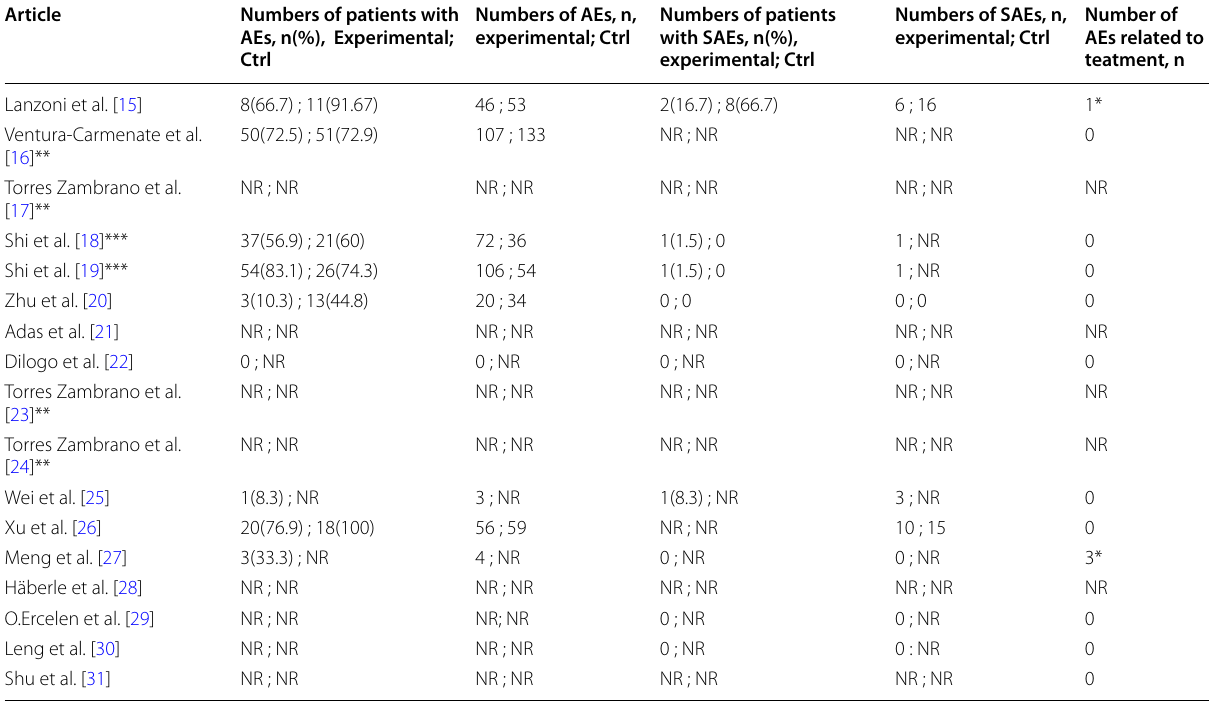
Table 2 Numbers of AEs and patients with